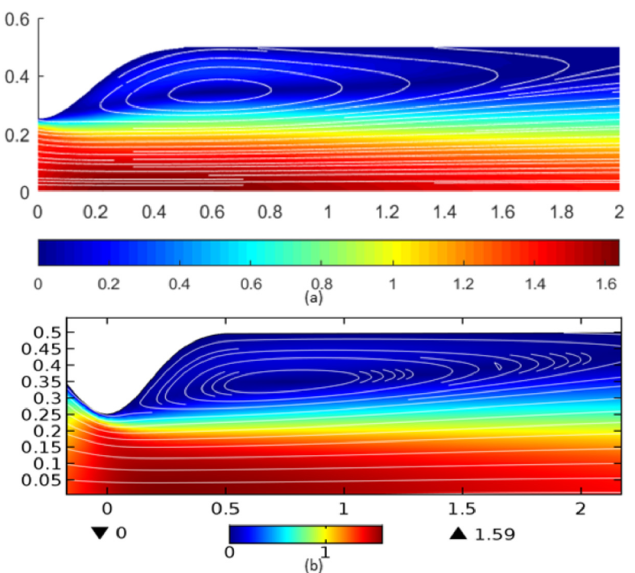
Fig 3. Velocity contour obtained from (a)Present study is comparable with (b)Comsol Multiphysics and